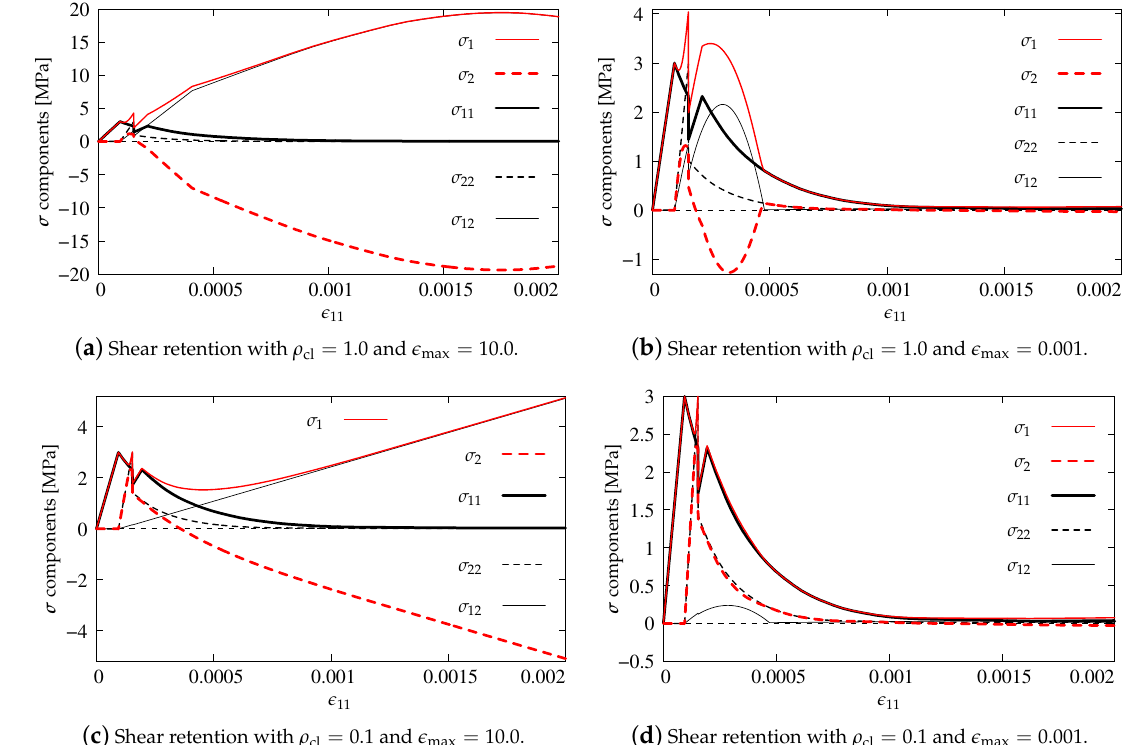
Figure 11. Comparison of stress components for the CSC